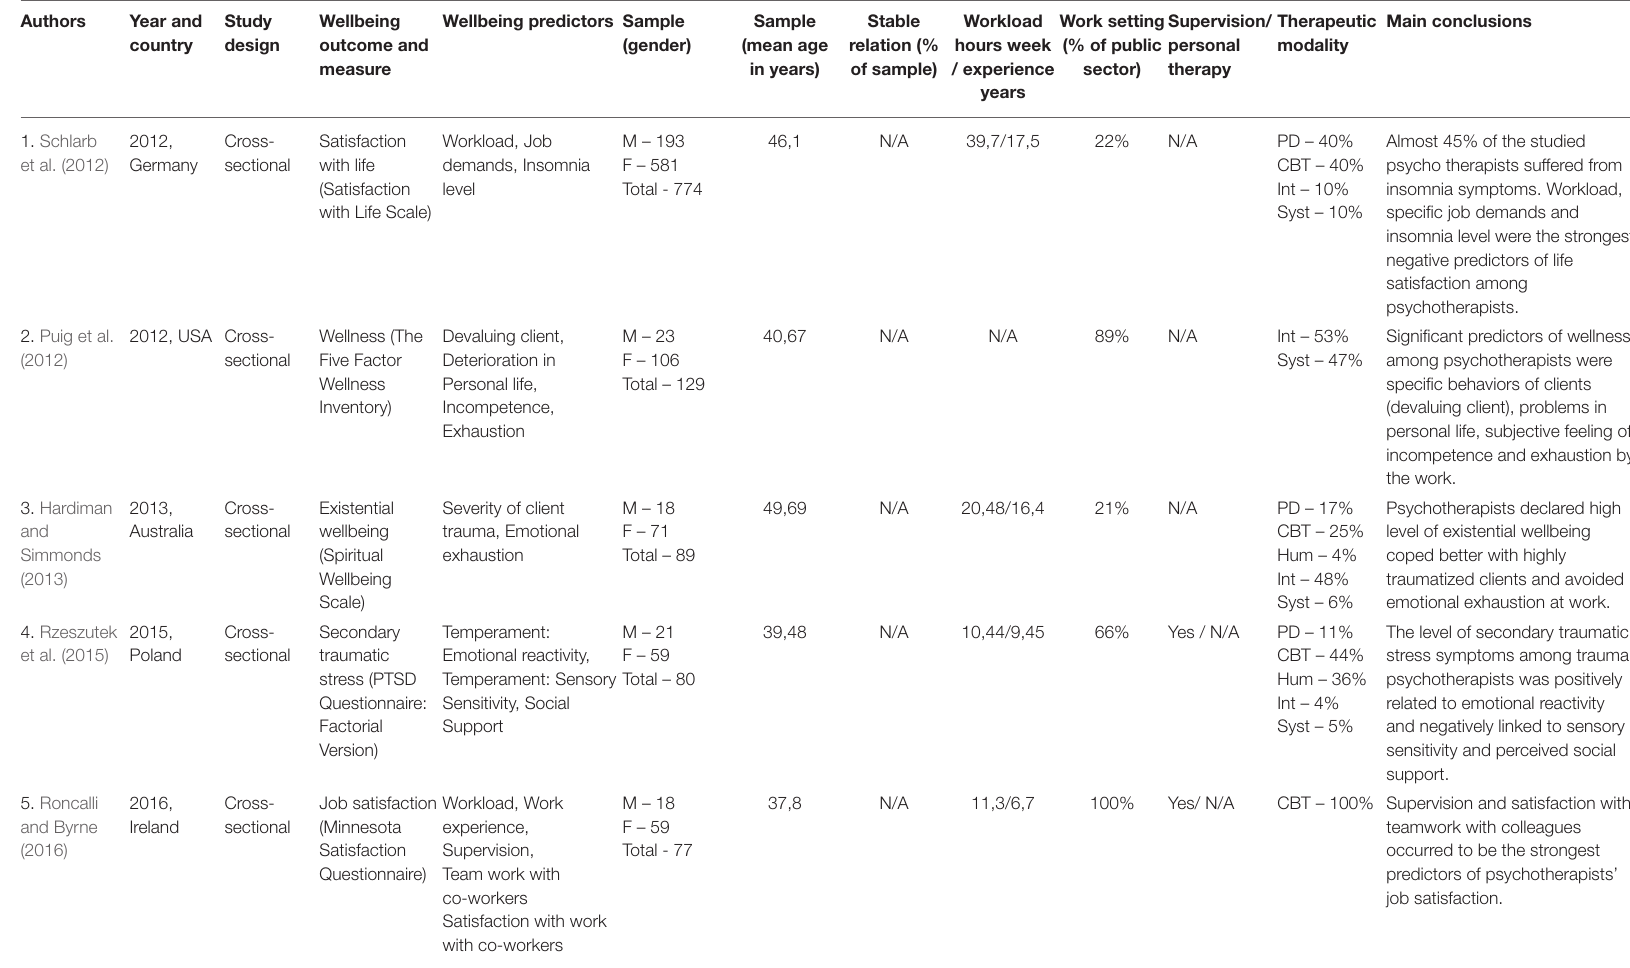
TABLE 2 | Summary of data on wellbeing among psychotherapists.